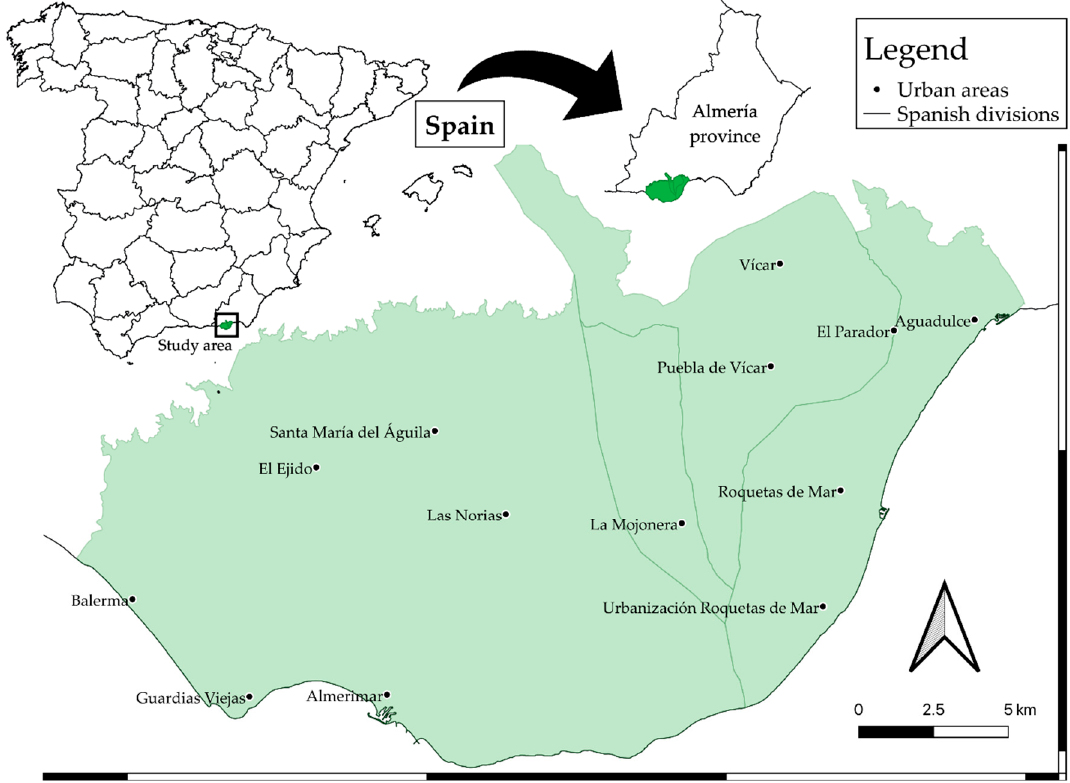
Figure 1. Study area. The Campo de Dalías corresponds to the area shaded in green.